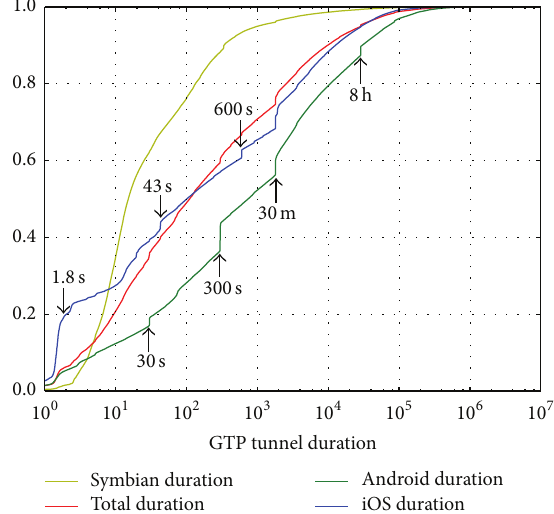
Figure 5: Tunnel duration cumulative distribution function, sepa- rated for Android and iOS